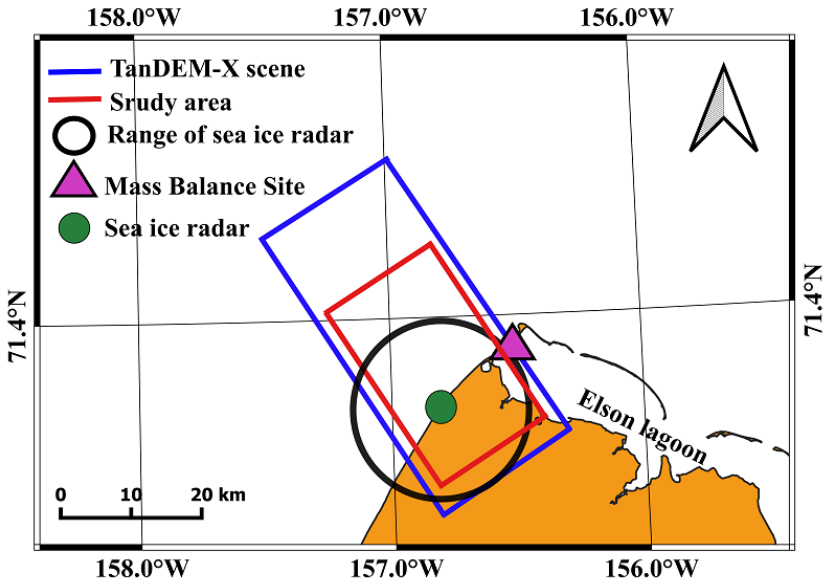
Figure 1. Study area with the TanDEM-X scene outlined in blue. The subset used (i.e., study area) is marked with a red rectangle. The black circle indicates the nominal range of sea ice radar. Land is masked out in orange.